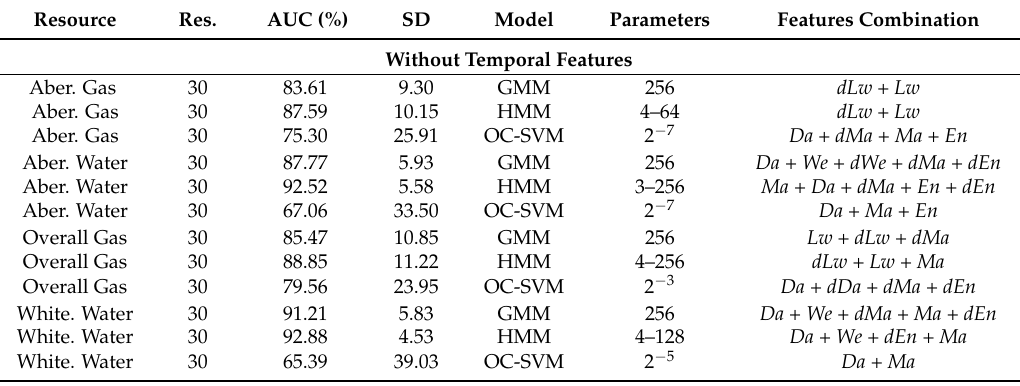
Table 5. Best results and corresponding features’ combination achieved for each resource and resolution ( Res. ) of the Department of International Development (DFID) dataset. The Abercrombie and the Whitehall sets are reported as “Aber.” and “White.”, respectively. The column “ Parameters ” reports the number of Gaussians, the states and Gaussians number and the γ value for GMM, HMM and One-Class (OC)-SVM,